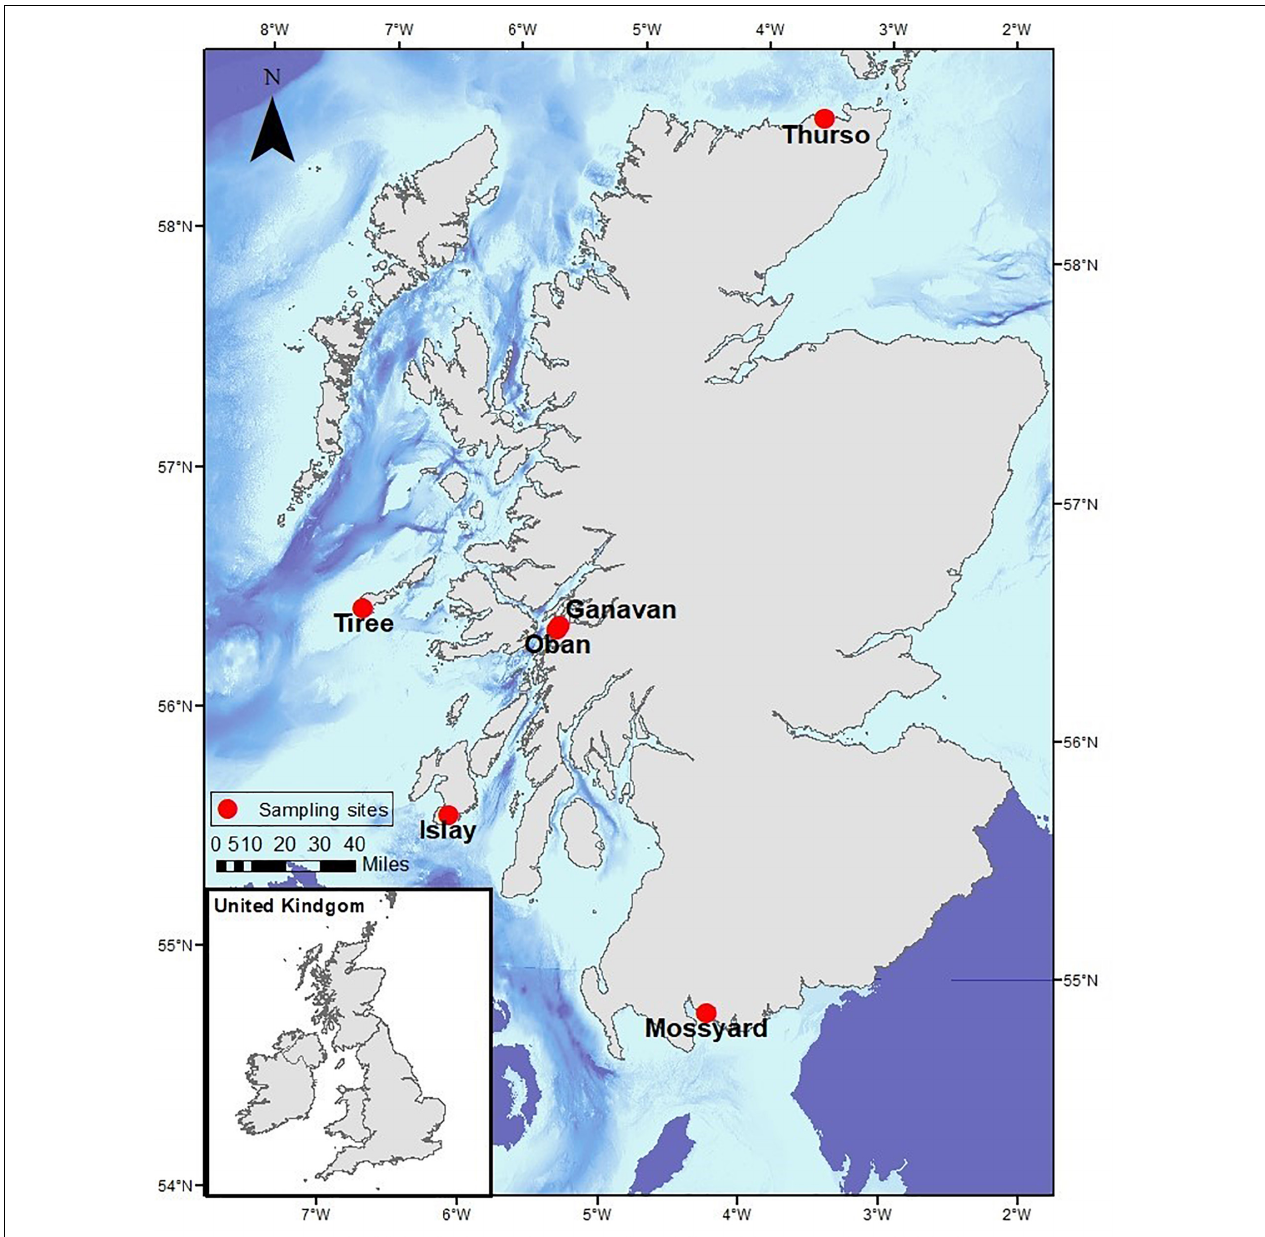
FIGURE 1 | The six sampling sites around the West and North coasts of